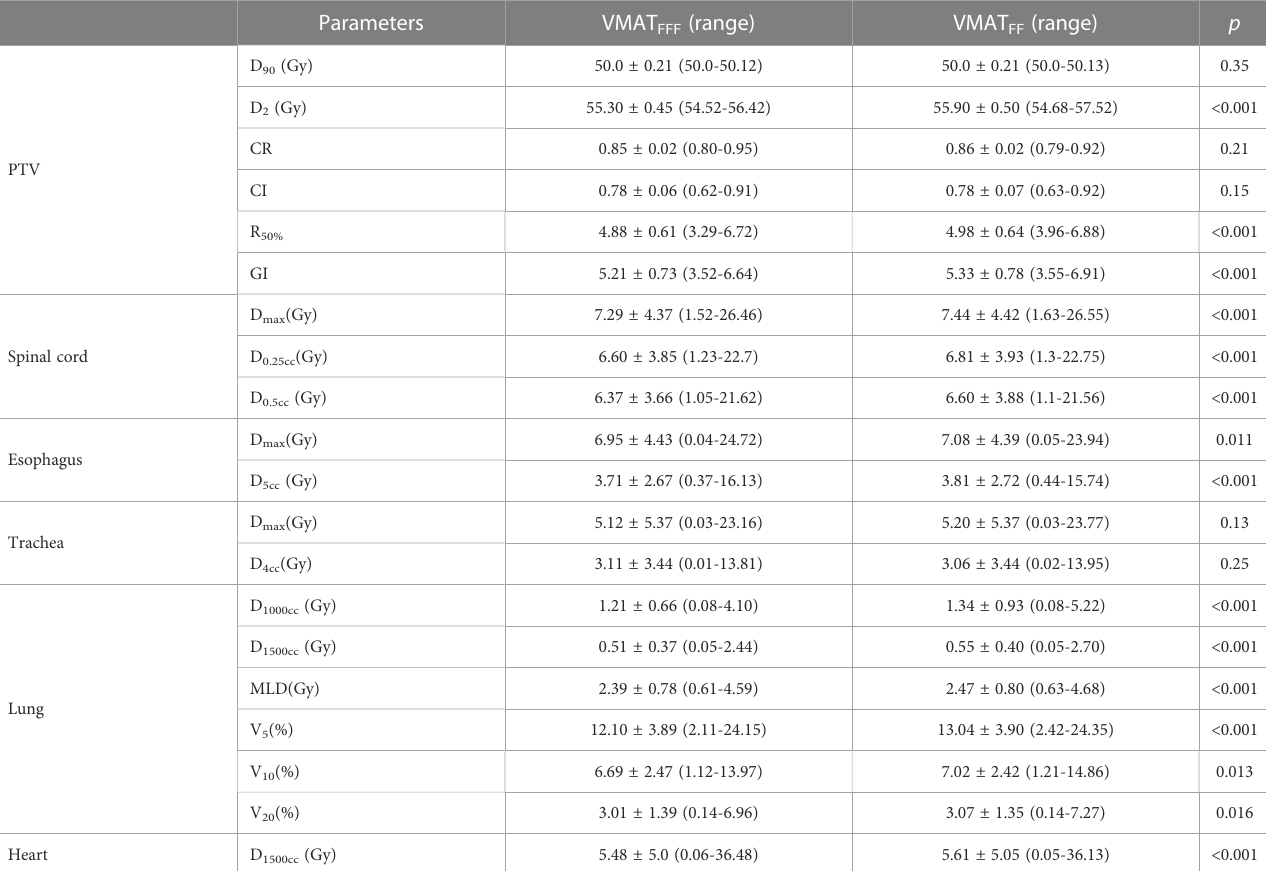
TABLE 4 Comparison of the dosimetric parameters (mean ± standard)of PTV and